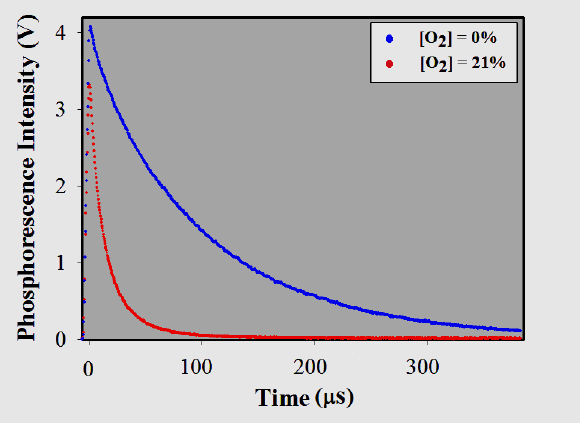
Figure 6. Phosphorescence decay for IrTFPP-CO-Cl immobilized in